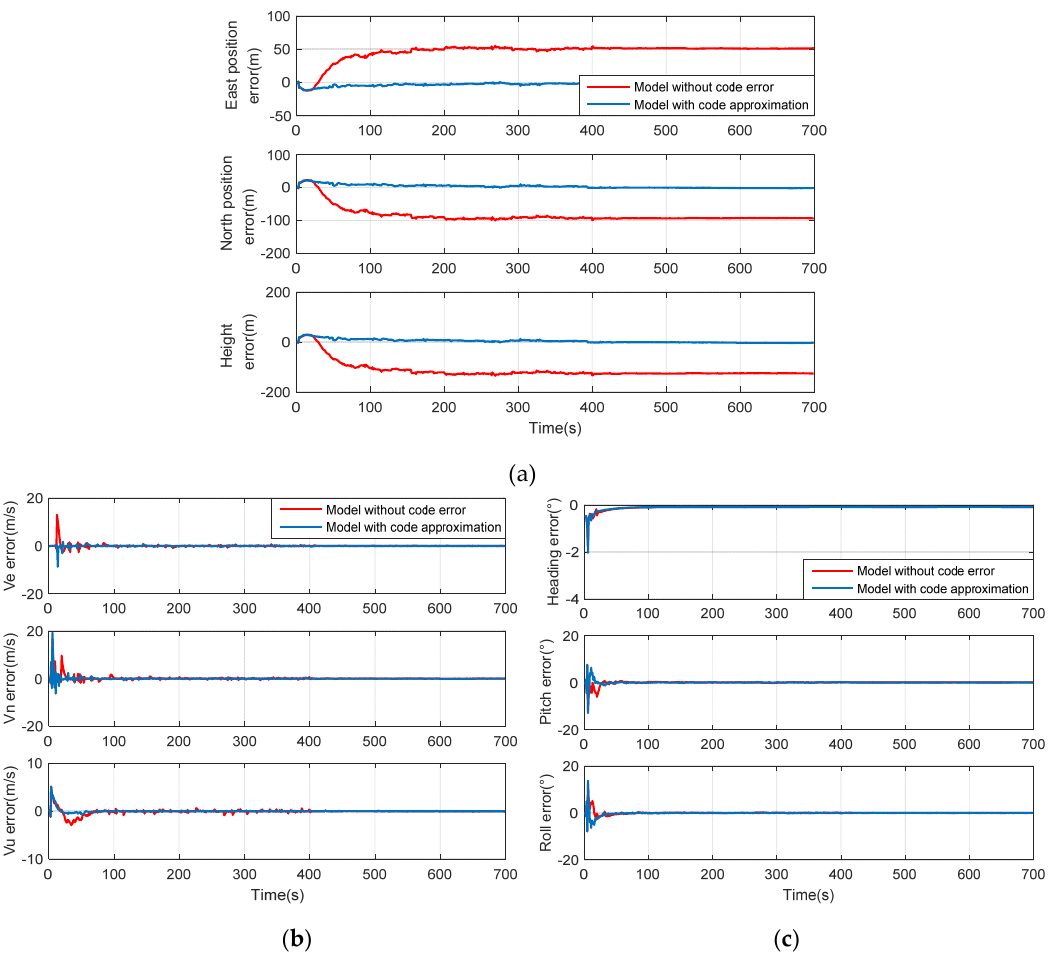
Figure 8. Comparison between the model without code error and with code approximation when tracking loop is oscillatory. ( a ) Position errors; ( b ) velocity errors; ( c ) attitude errors.